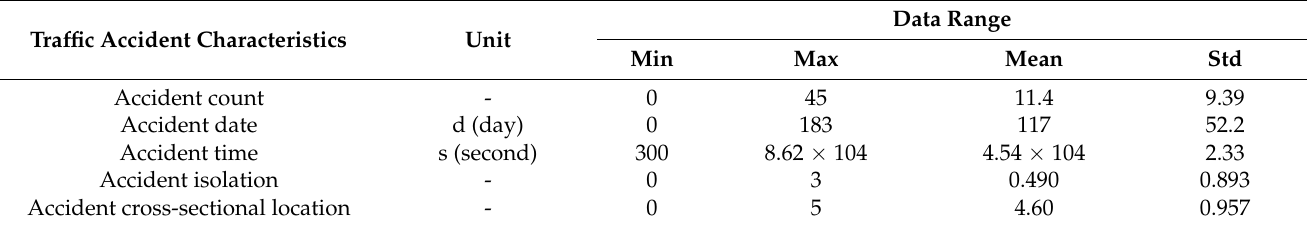
Table 2. The overview of the accident characteristics.